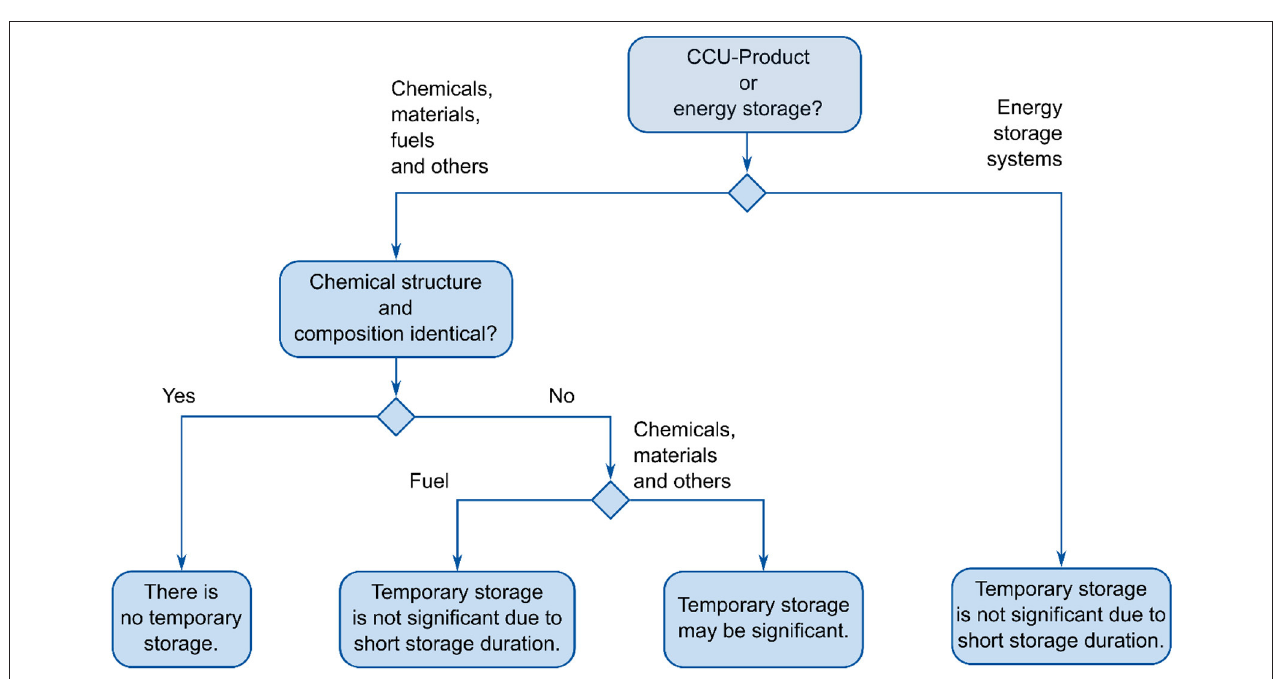
FIGURE 8 | Emissions time profiles for different products. CO 2 -based products with identical chemical structure and composition to their conventional counterparts have identical emissions timing profiles after production. CO 2 -based products different in chemical structure and composition can have different emissions during use-phase and end-of-life treatment and different life spans and thus, the emissions timing profile can be different.